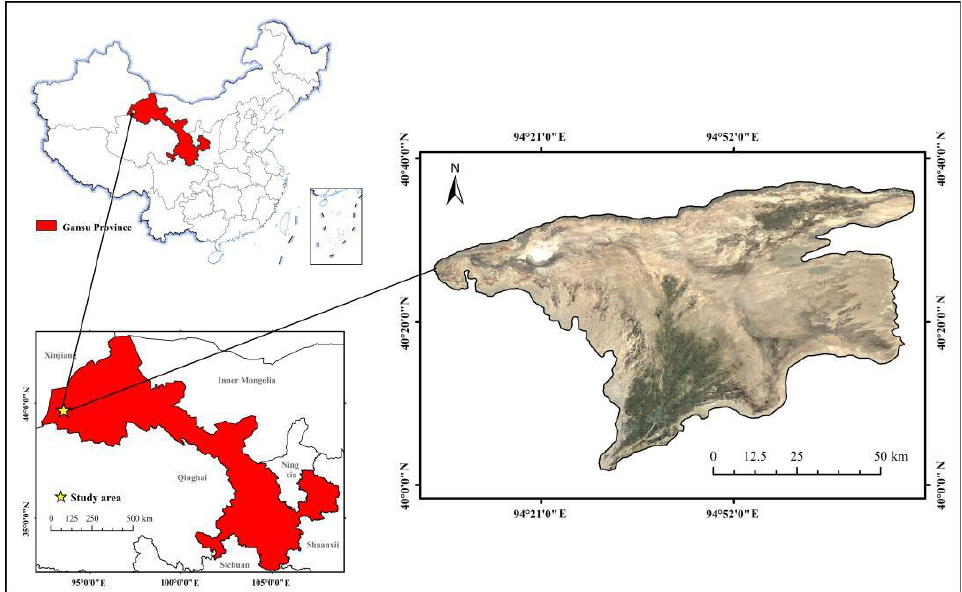
Figure 1. Geographic of the study area.